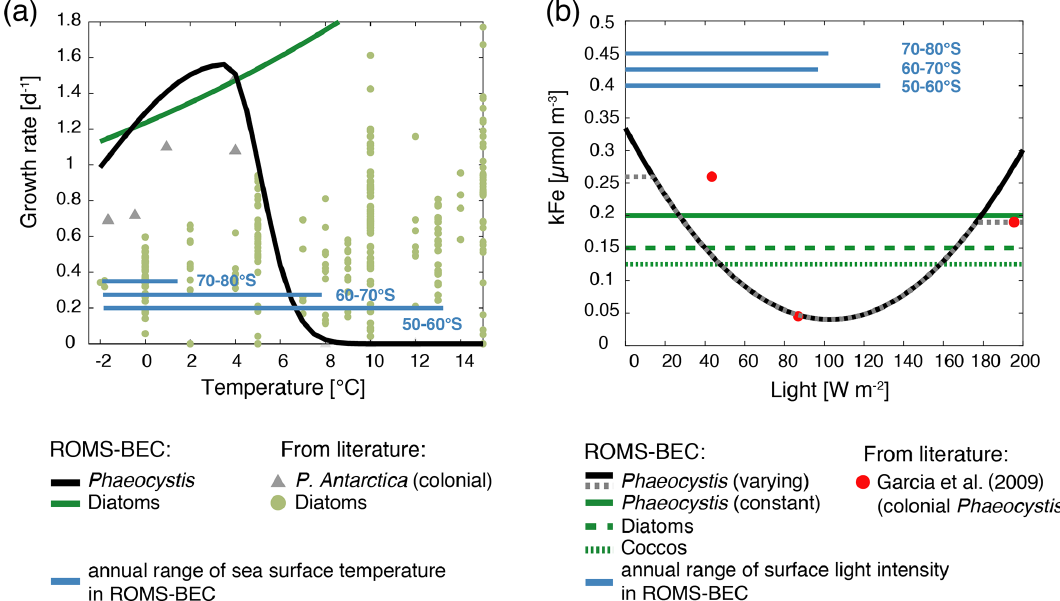
Figure A1. (a) Growth rates of Phaeocystis antarctica colonies as a function of temperature (conditions of nutrients and light are non- limiting) in laboratory data (grey triangles; see compilation by Schoemann et al., 2005) and as used in ROMS-BEC (black line; see Eq. 1). Green circles and the green line show the temperature-limited growth rate of diatoms in laboratory data (see compilation by Le Quéré et al., 2016) and as used in ROMS-BEC, respectively (see also Table 1). (b) Half-saturation constant of Fe ( k Fe ) of Phaeocystis as a function of light (I) = 2 . 776 × 10 − 5 × (I + 20 ) 2 − 0 . 00683 × (I + 20 ) + 0 . 46) intensity I (Wm − 2 ) in laboratory data (red circles) and the polynomial fit ( k PA Fe without (black) and with (dashed gray, as used in ROMS-BEC in simulation VARYING_kFe; see Table 2) the correction at low and high light intensities to restrict k Fe to the range measured in the laboratory experiments by Garcia et al. (2009). The green lines correspond to the half-saturation constants used for Phaeocystis (solid), diatoms (dashed), and coccolithophores (dotted) in the Baseline simulation in this study (see Table 1). In both panels, the blue lines correspond to the simulated annual range in (a) sea surface temperature ( ◦ C) and (b) light intensity (Wm − 2 ) between 50–60, 60–70, and 70–80 ◦ S, respectively.